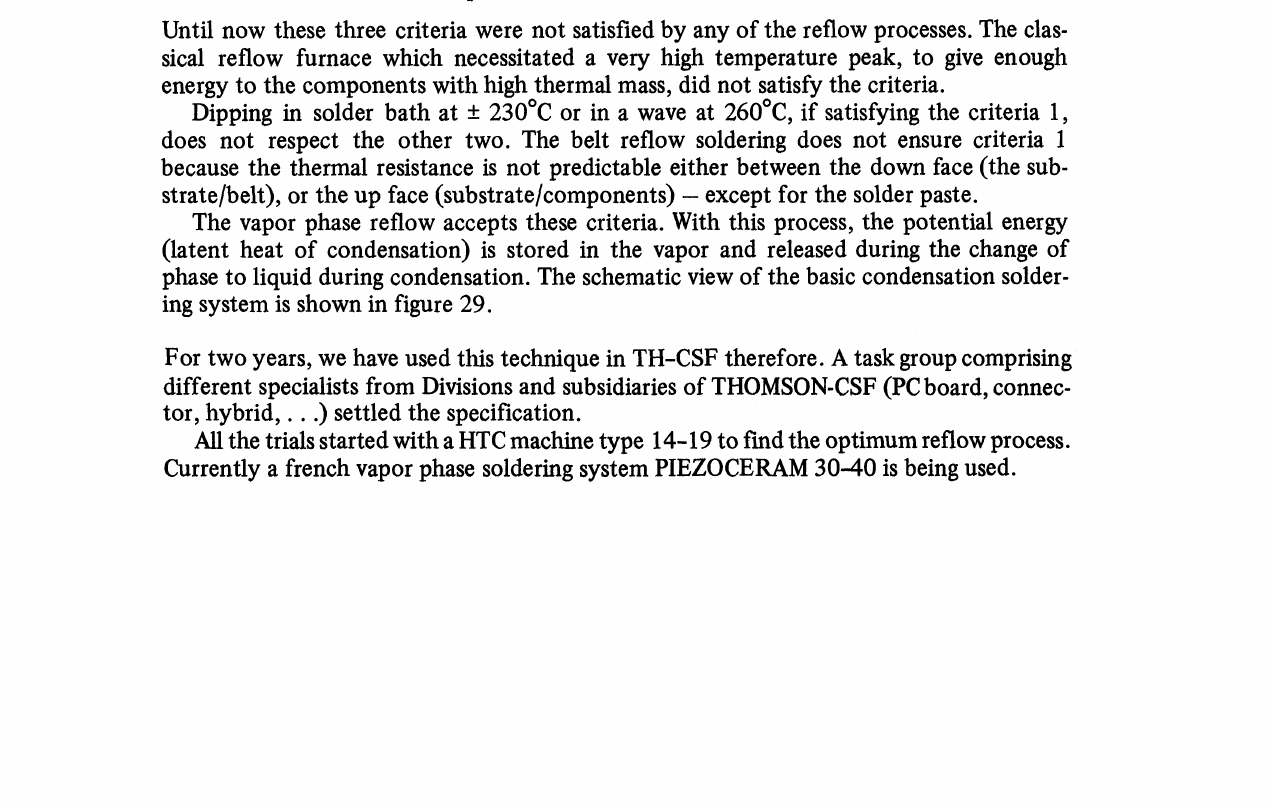
FIGURE 29 Schematic, representation of the basic condensation soldering